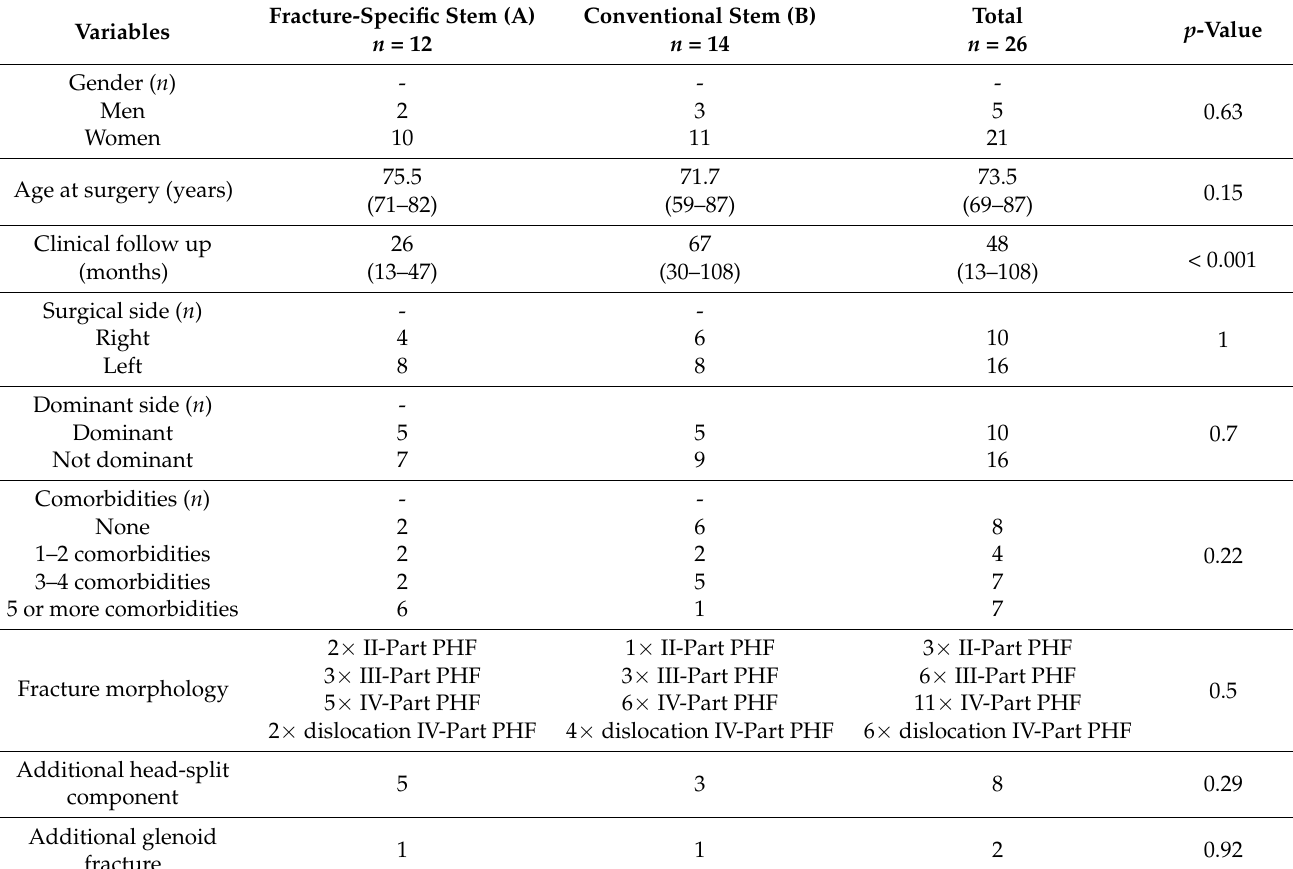
Table 1. Patient demographics and fracture morphologies with regards to all patients with clinical follow-up.